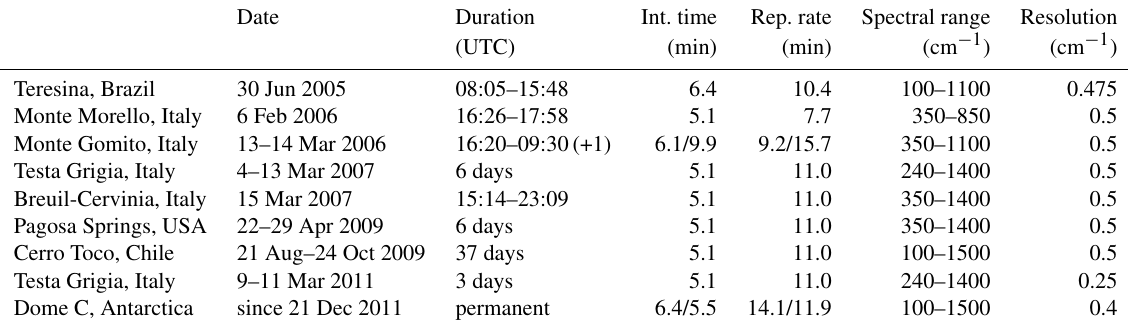
Table 1. Data available from the measurement campaigns performed by the REFIR-PAD instrument. Integration time corresponds to the actual acquisition time in zenith-looking mode used to produce a single spectrum, while the repetition rate accounts for the total duration of the acquisition including calibrations and system overhead.